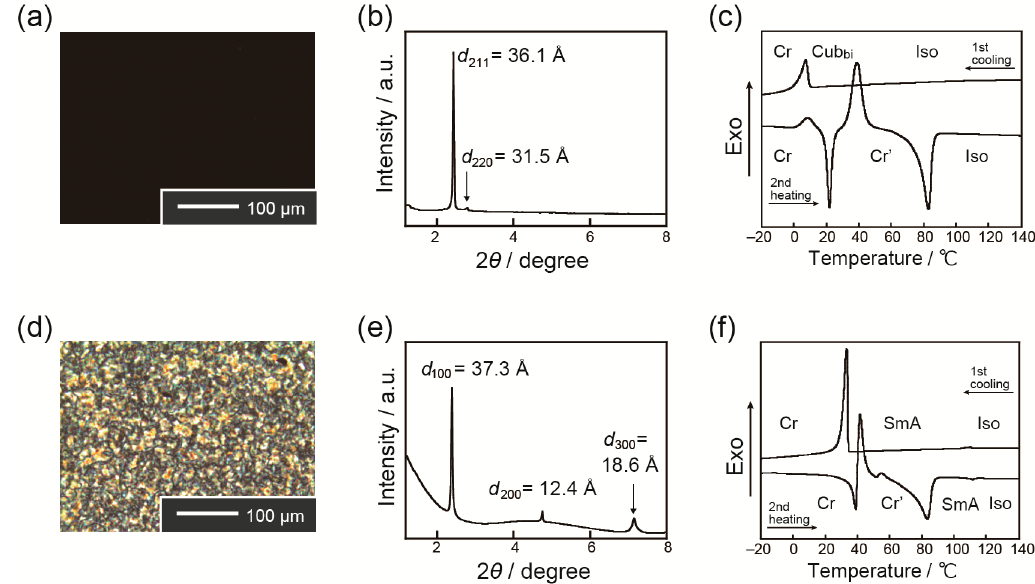
Figure 2. ( a ) Polarizing optical microphotograph of 1 in the bicontinuous cubic (Cub bi ) phase at 30 ◦ C. ( b ) X-ray di ff raction (XRD) pattern of 1 in the Cub bi phase at 30 ◦ C. ( c ) Di ff erential scanning calorimetry (DSC) thermograms of 1. ( d ) Polarizing optical microphotograph of 3 in the smectic A (SmA) phase at 50 ◦ C. ( e ) XRD pattern of 3 in the Sm phase at 50 ◦ C. ( f ) DSC thermograms of 3.